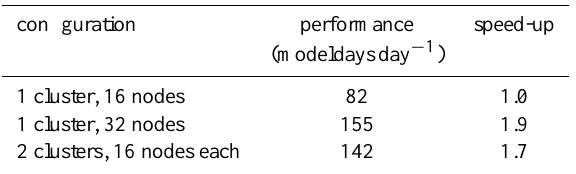
Table 3. Speed-up on DAS-4 for one- and two-cluster configura- tions using a hierarchical domain